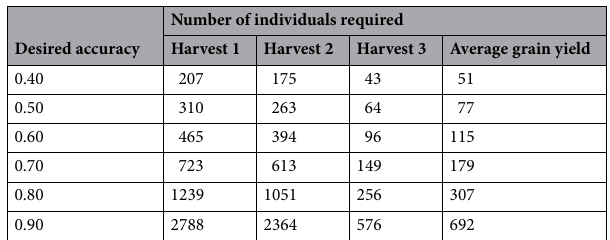
Table 3. Number of individuals required to obtain the desired accuracy of GWS in the Jatropha population for grain yield.